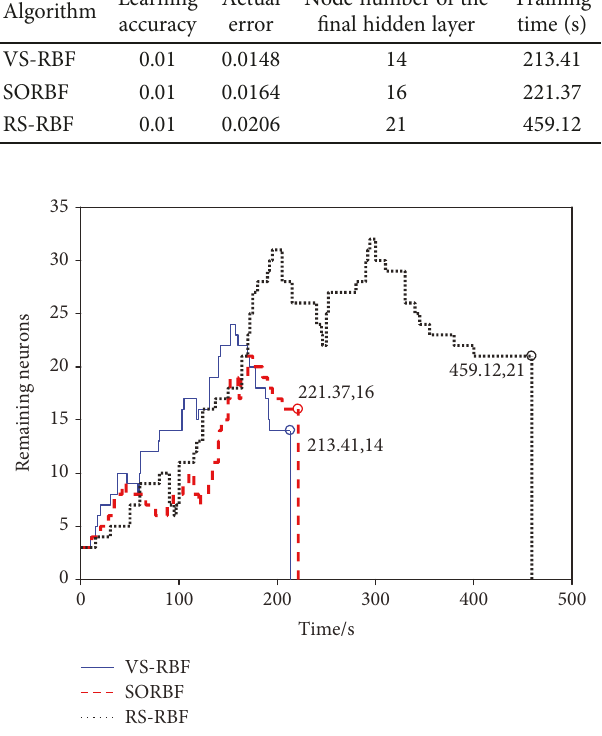
Figure 6: Number of remaining neurons in SIF training.